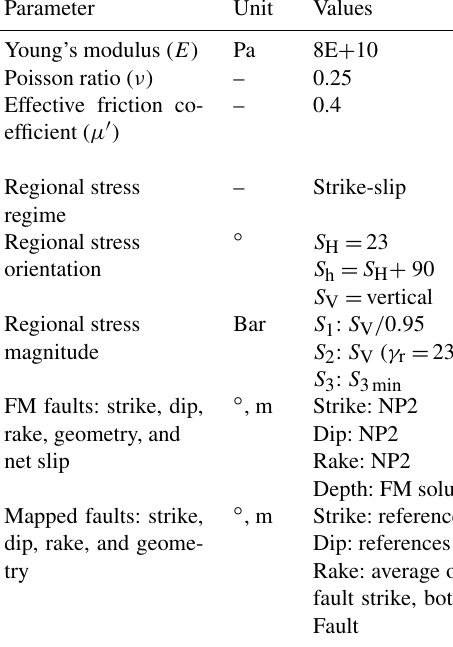
Table C2. Best estimate (BE) of parameters in order to compute (cid:49) CS. Parameter Unit Values Source & method 8E + 10 Assumed value (Toda et al., 2011b) –